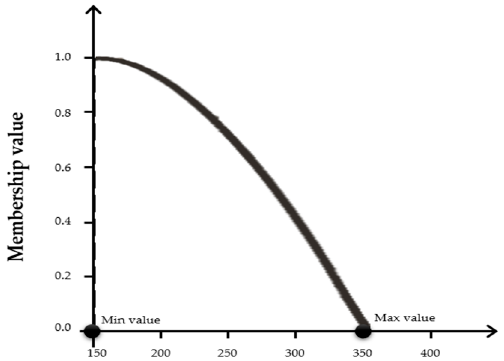
Figure 5. Membership function corresponding to the cosine curve [61].